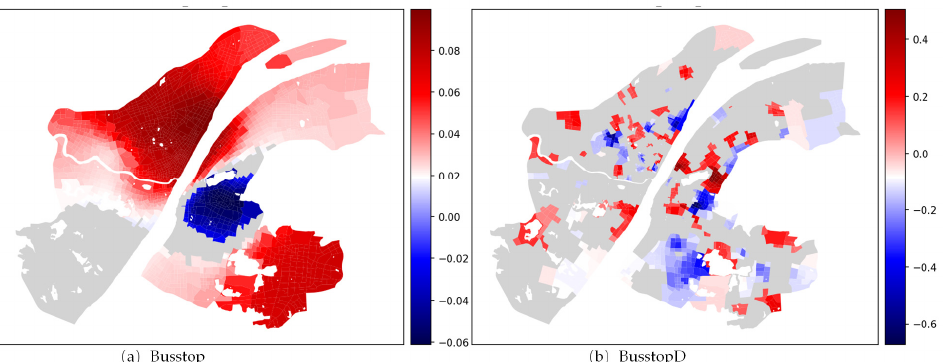
Figure 9. Multiscale effect of the accessibility of bus stops. ( a ) Kernel density of bus stops, ( b ) Distance to nearest bus stop.